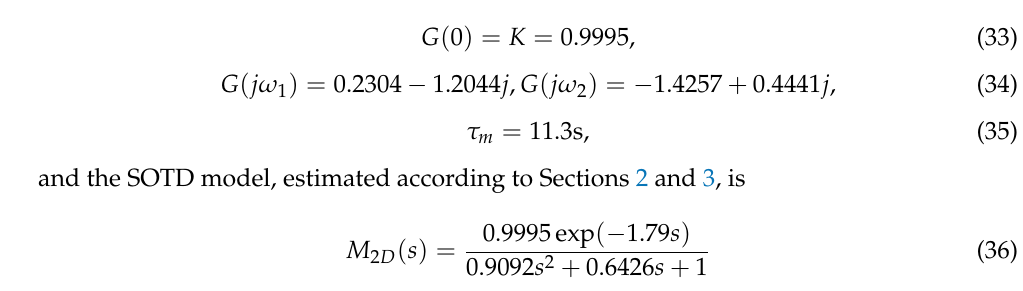
and the SOTD model, estimated according to Sections 2 and 3, is